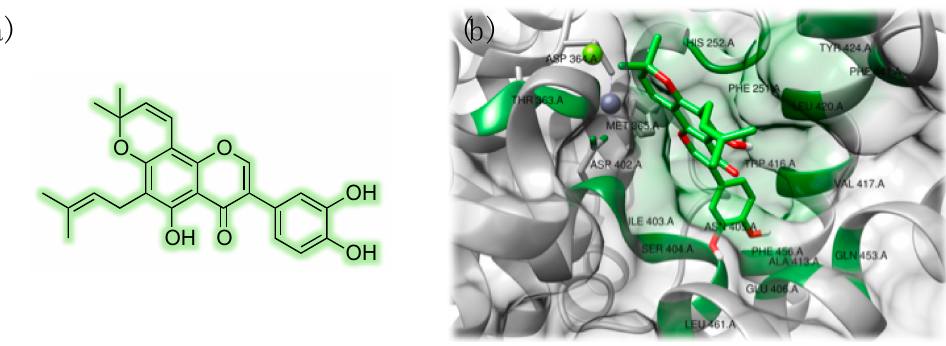
Figure 5. Chemical structure of pomiferin ( a ). Detailed 3D view of the predicted interaction motif with PDE9: zinc is represented in purple and magnesium is reported in green. Interacting residues have been labeled and highlighted in green ( b ). Interaction model was built based on the computational data reported by Ongaro et al. [54].